Question: State the chart type depicted above.
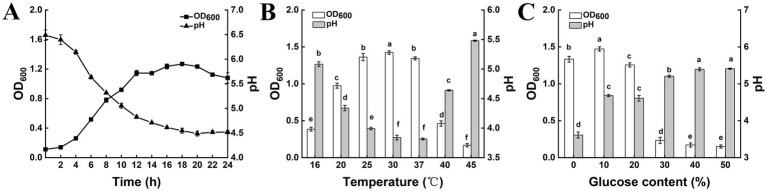
Answer: line